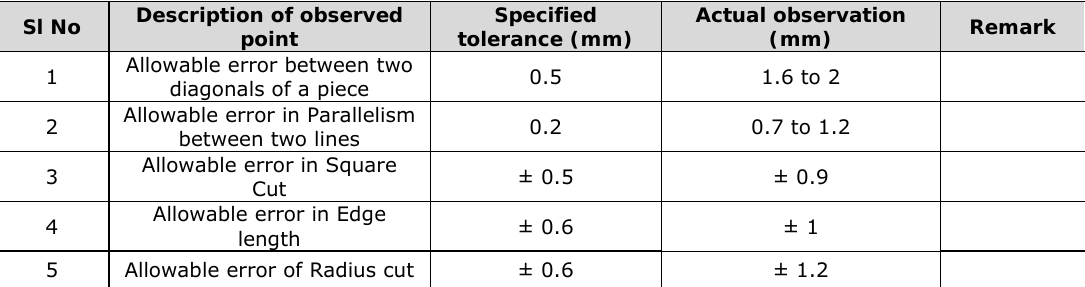
Table 4. “Dimensional problems (result of group observation technique)”